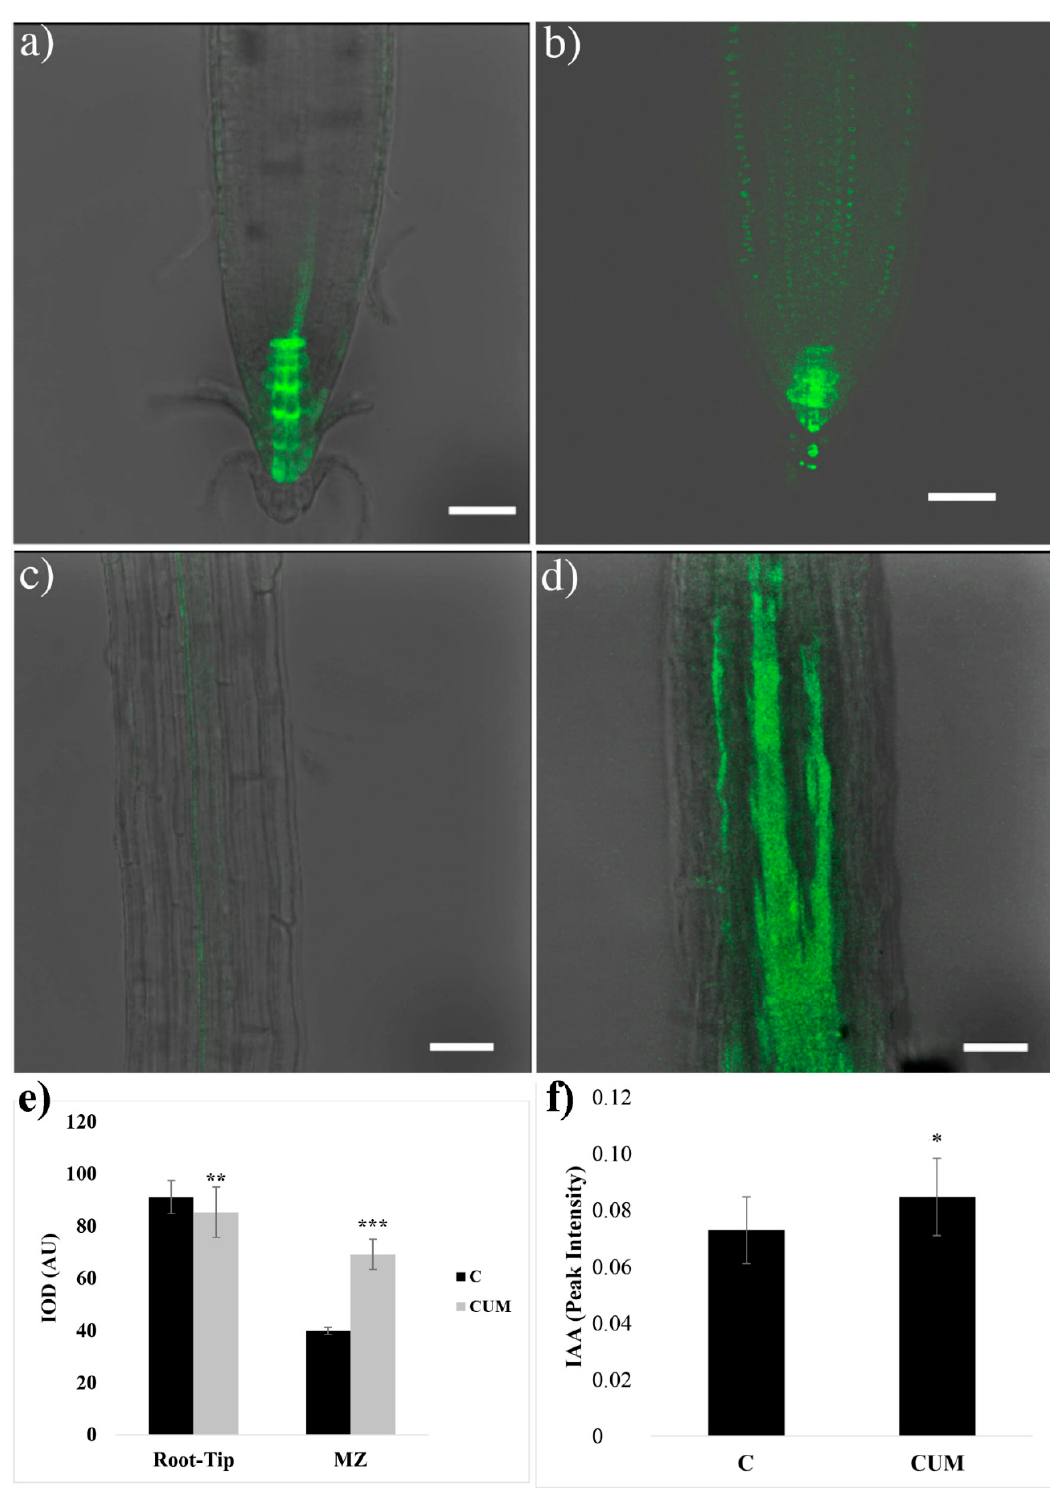
Figure 5. Fluorescence detection in 4 days old A. thaliana pDR5::GFP transgenic line (auxin responsive reporter) grown for 48 h in untreated agar medium (( a ) (RAM) and ( c ) (elongation zone)) or 100 µM of coumarin enriched agar medium (( b ) (RAM) and ( d ) (elongation zone)). Scale bars 34 µm. N = 20. ( e ) Integrated optical density (IOD) expressed as arbitrary units (AU) of fluorescence intensity measured in the root tip and the MZ (maturation zone) of Arabidosis treated for 48 h with 0 or 100 µM of coumarin (N = 10); ( f ) auxin content in Arabidosis roots treated for 48 h with coumarin 0 (C) or 100 (CUM) µM. Data are presented as mean ± standard deviation (SD). Statistical analysis was performed using the Student’s t -test with * p ≤ 0.05, ** p ≤ 0.01, *** p ≤ 0.001. N = 4.